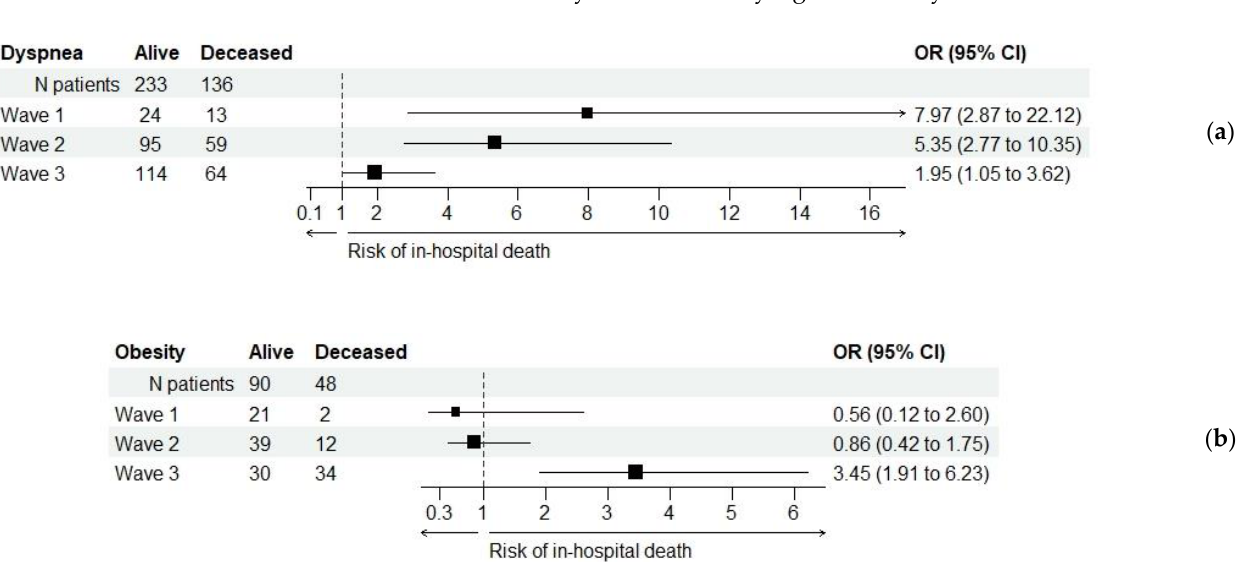
test, p = 0.022), although it remained statistically significant in all three wave groups. The risk